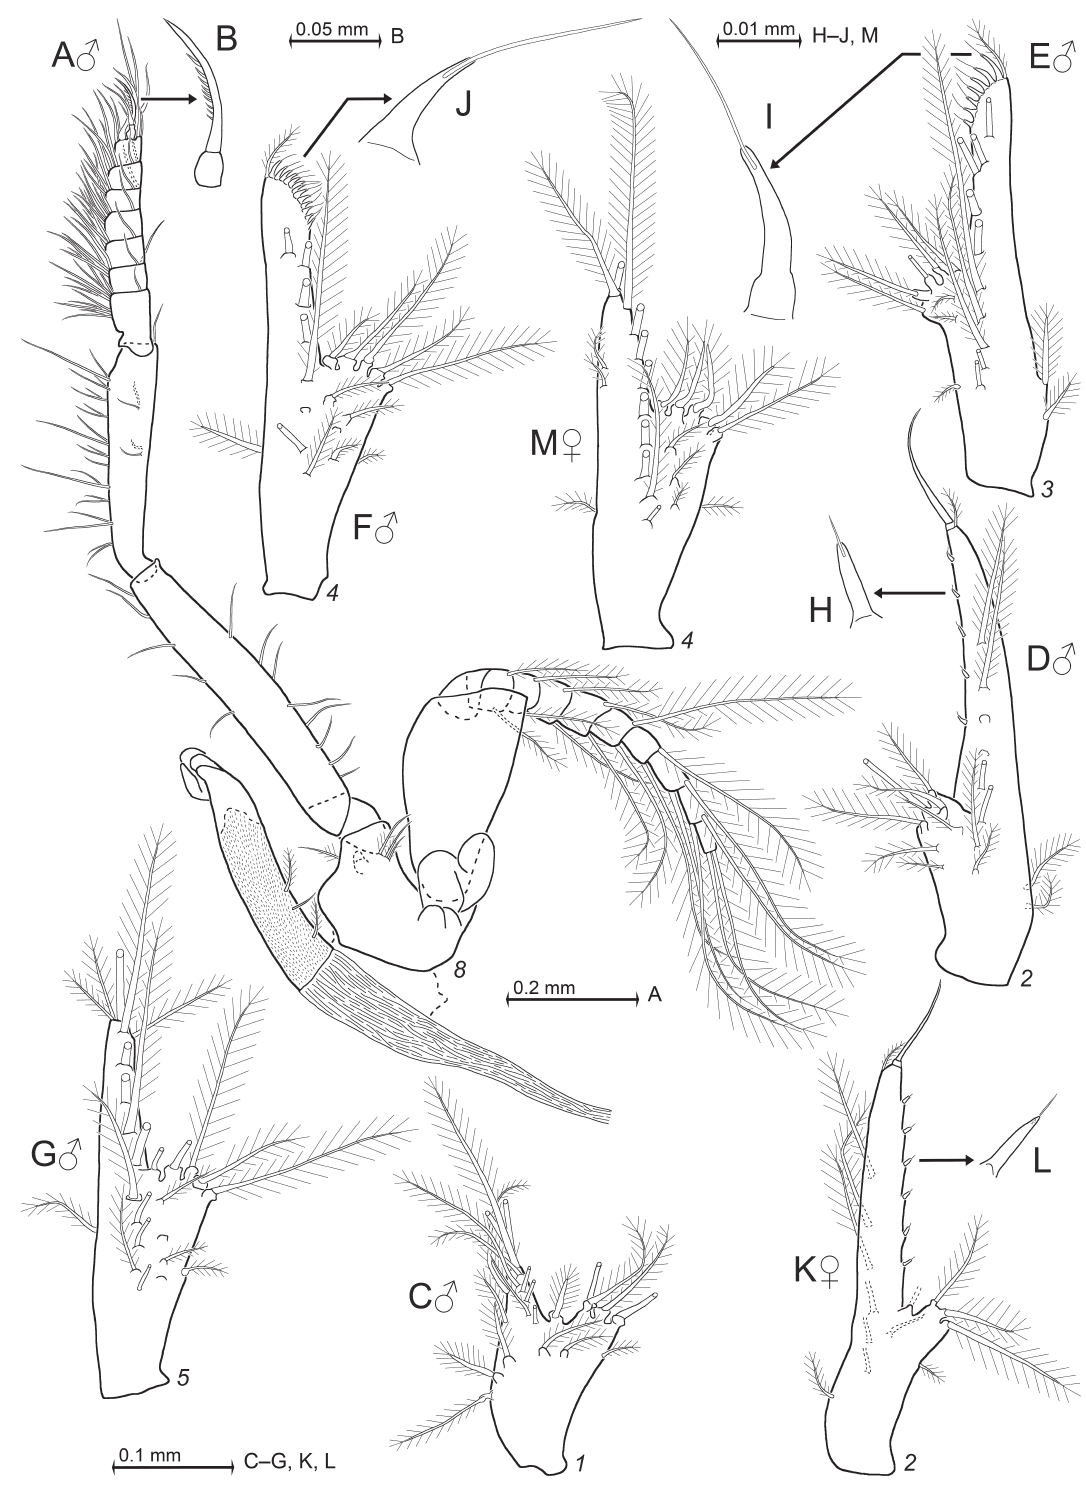
Fig. 11. Heteromysis waikikensis sp. nov., paratypes, ♂ 4.2 mm (A–J: NHMW 26967 ) and ♀ 4.2 mm (K–M: NHMW 26966). A . Thoracopod 8 with penis, rostral view. B . Detail of thoracic endopod 8 (A) showing dactylus with nail. C–G . Male pleopods 1–5, represented by left (C, F–G) and right (D–E) ones; caudal. H–J . Flagellate spines of male pleopods 2–4 (D–F). K . Right female pleopod 2, rostral. L . Detail of female pleopod 2 (K) showing flagellate spine. M . Left female pleopod 4,